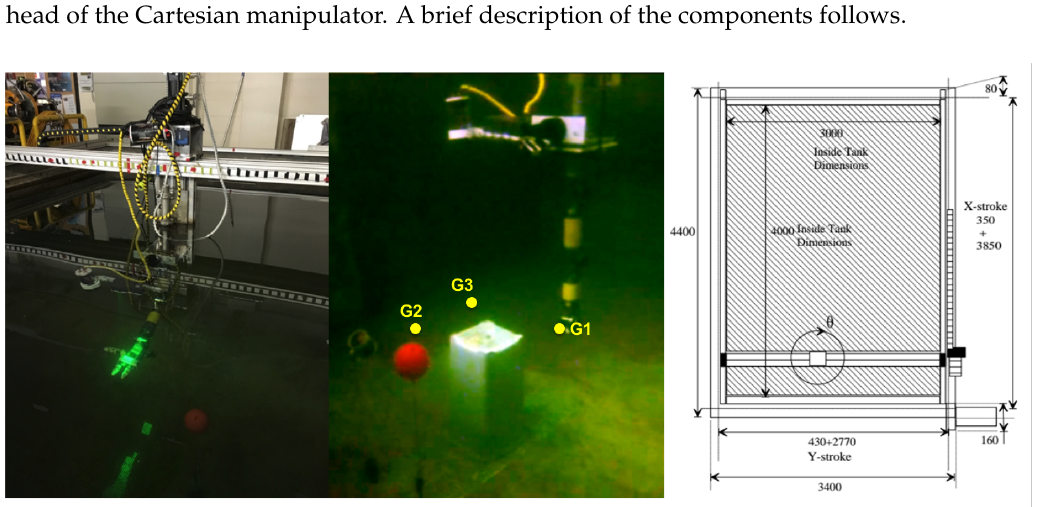
Figure 4. Water tank with the six DoF robot arm mounted on the head of the Cartesian manipulator ( left ); underwater scene with the three way-points defined for the experiment (centre; see Section 5.2); sketch of the Cartesian manipulator ( right ; units in